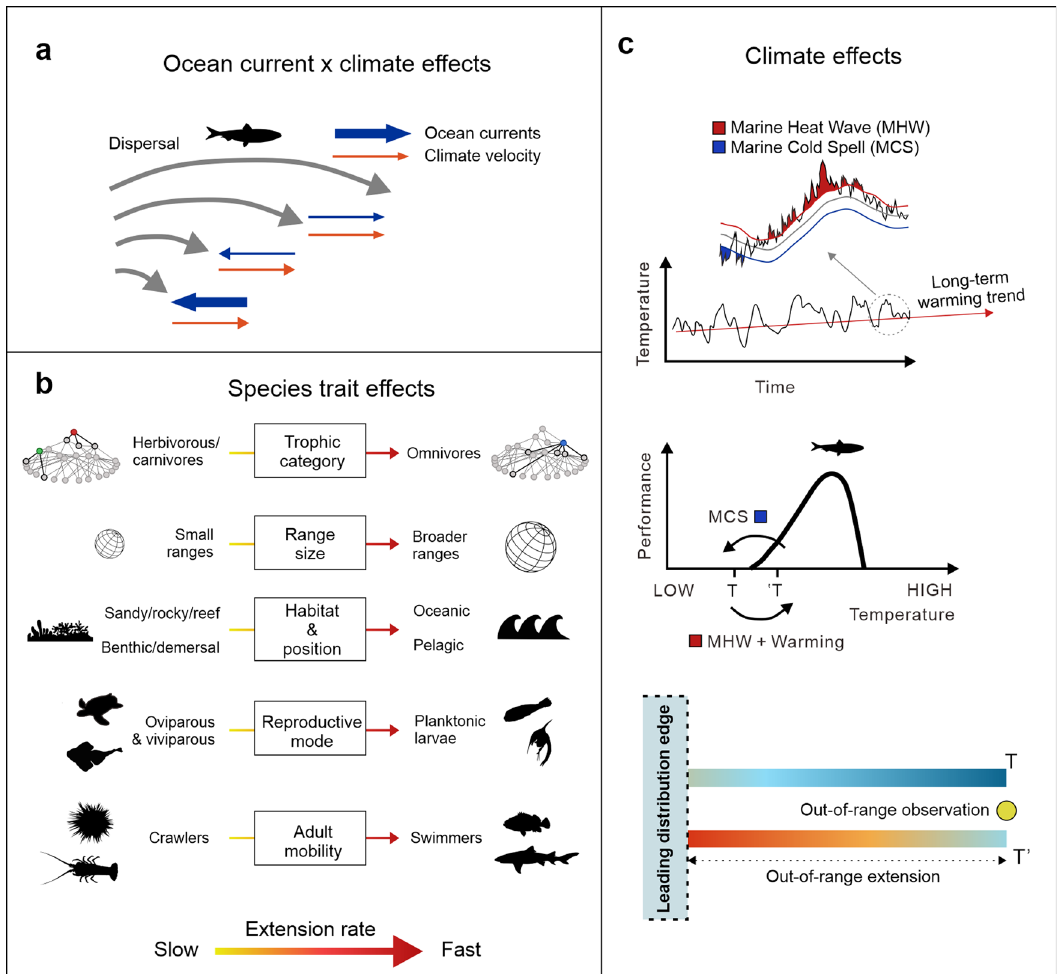
Fig. 1 Schematic of a priori expectations for the role of physical and biological predictors in driving extension distances associated with out-of-range observations. a Through their effect on dispersal, ocean currents may facilitate or hinder this process depending on their transport capacity (represented by the thickness of the blue arrow) and their directional agreement with the displacement of thermal environments under warming. b Biological identity is also expected to in fl uence responses to warming based on traits related to the dispersal potential of adults and larvae, dependency on speci fi c habitats, trophic category and historical range size (see text for details). c Dispersal of individuals beyond the leading, cooler edge of a species distribution are expected to respond to extensions of its thermal niche under the combined effects of long-term, gradual warming and transient, episodic events (marine heat waves, MHW) as areas outside of the distribution initially too cold for the species (T) become thermally suitable (T ’ ). Marine cold spells (MCS) may hinder or halt extensions by locally setting ambient temperatures below the species lower